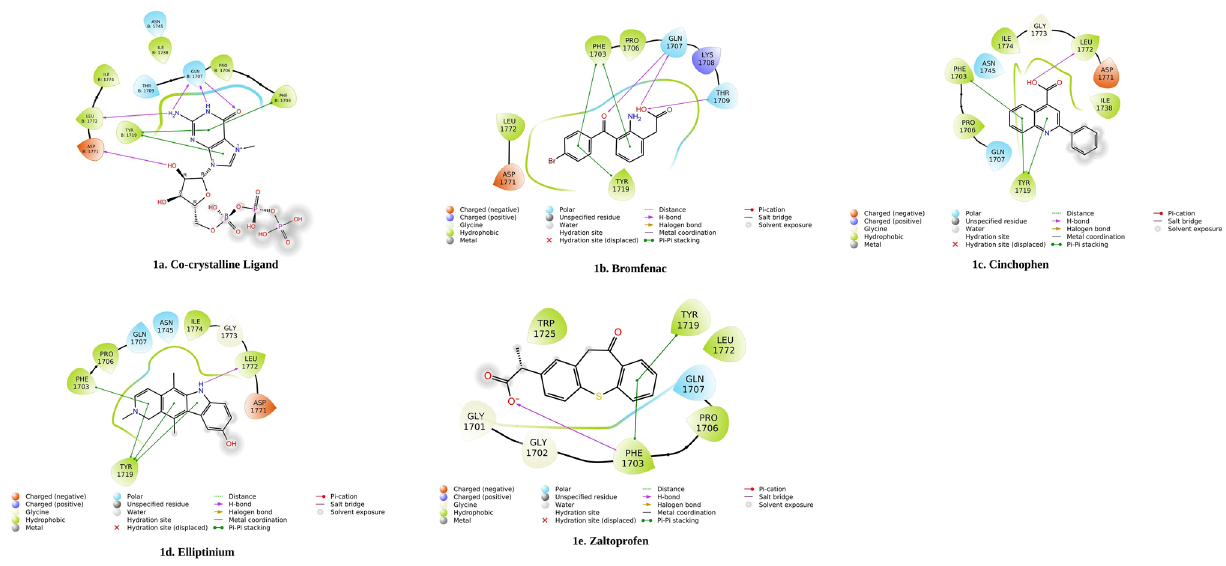
Figure 1. Two-dimensional interactions of top four ligands with the SFTS L